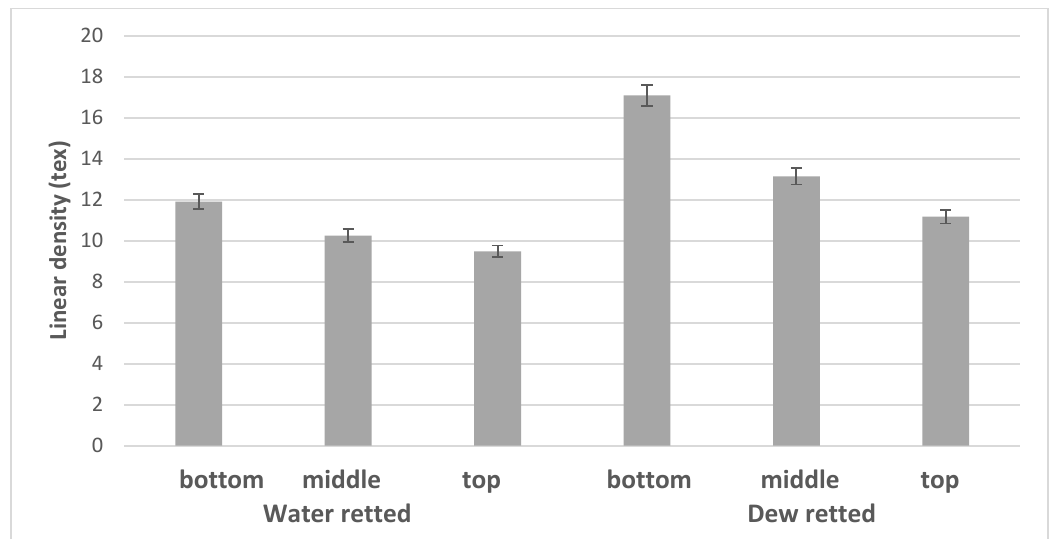
Figure 3. Effect of plant section used for fiber extraction and the retting method on the fiber linear density (tex) (Error bars represent standard errors).